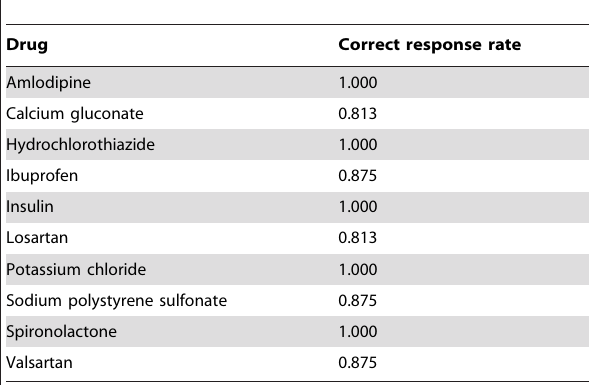
Table 2. Prescriber hyperkalemia knowledge regarding therapeutic decisions related to 10 hyperkalemia-related drugs, as determined by